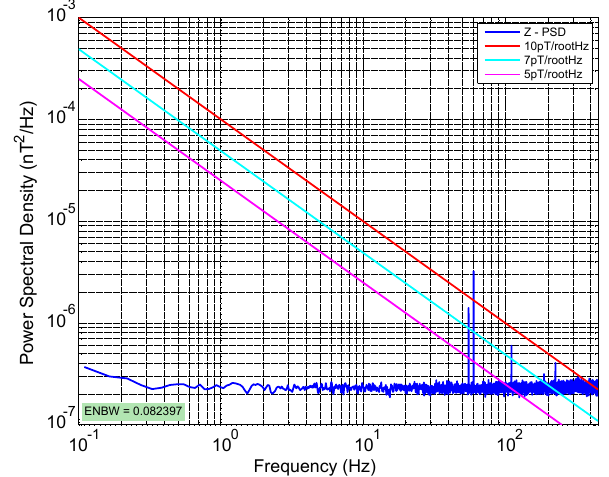
Fig. 13. Power spectral density noise floor of the electronics with the fluxgate sensor out of circuit.